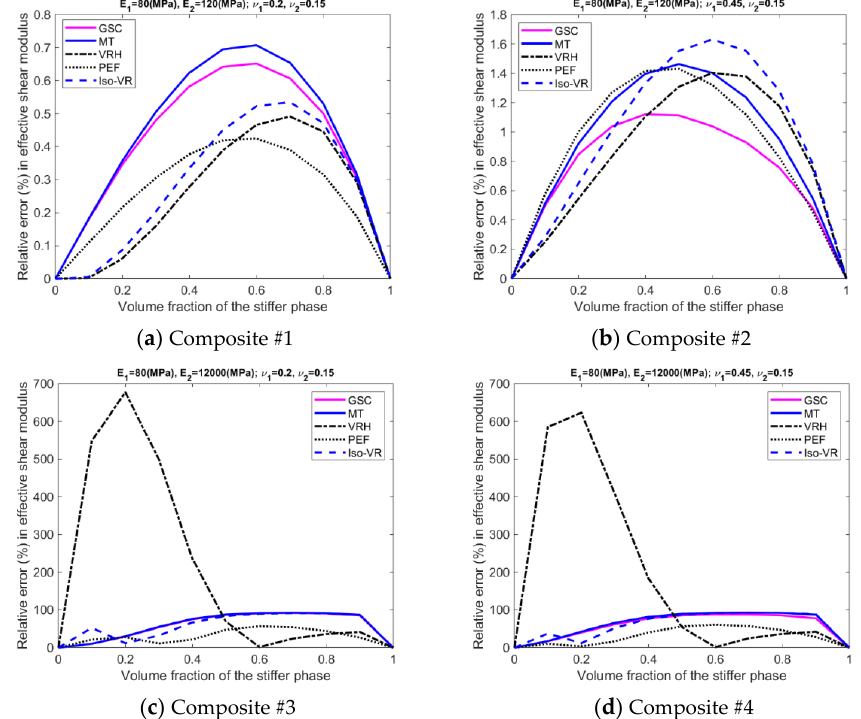
Figure A6. Relative error in effective shear modulus.